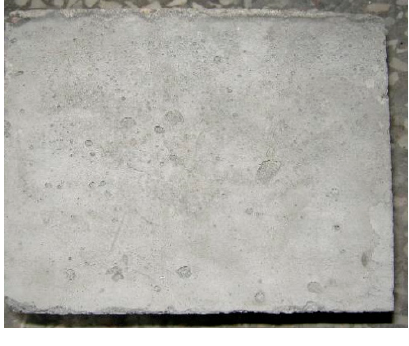
Figure 4. Isolation face.